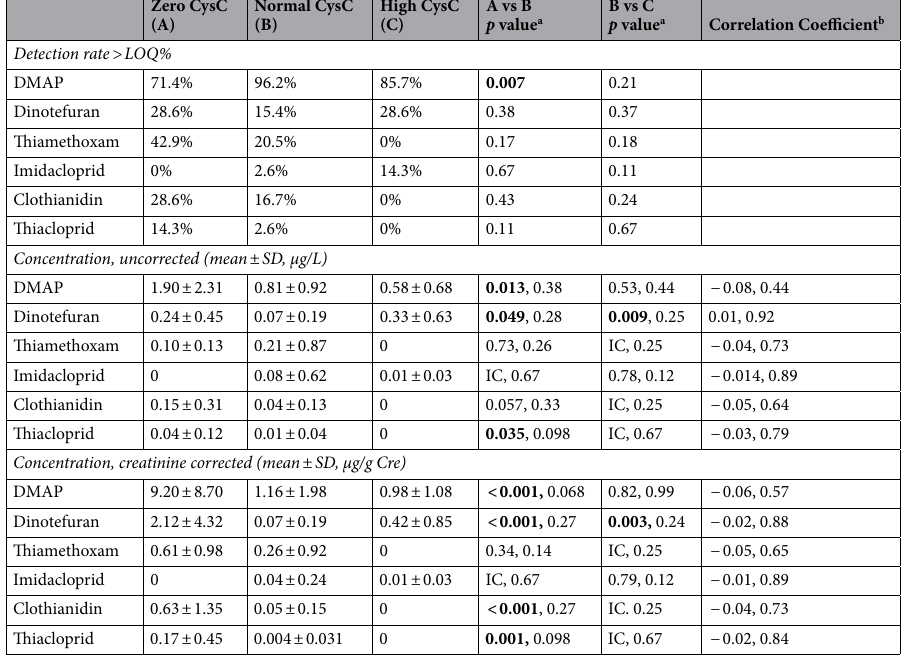
Table 9. Concentration and detection rate more than LOQ of urinary neonicotinoids and DMAP (μg/g Cre) in each class of urinary creatinine-adjusted Cystatin-C concentration. IC: incalculable; a For > LOQ%, Chi- square test, for neonicotinoids concentration, t test, Mann–Whitney U test (2-tailed); b Pearson correlation Coefficient between neonicotinoids/DMAP and Cystatin C in A, B and C, R, p